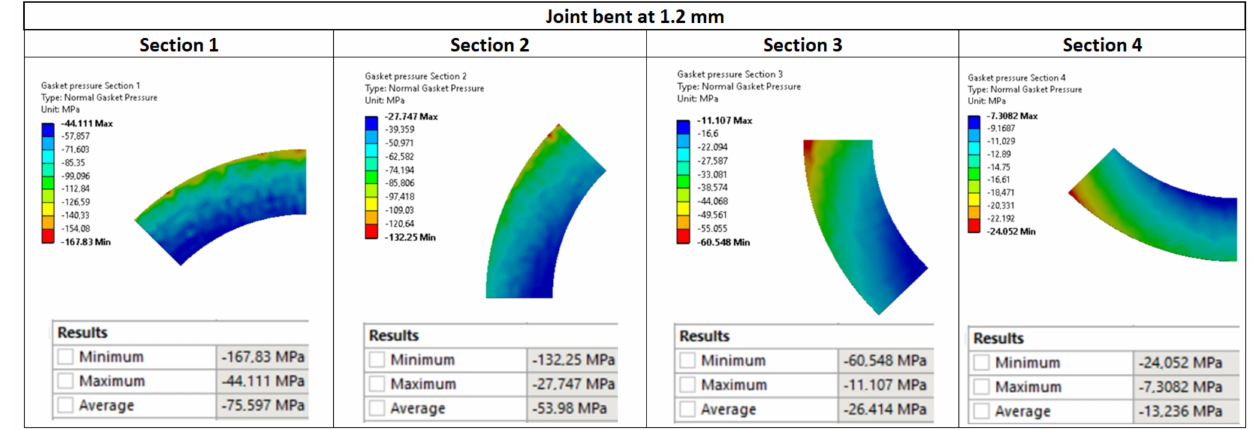
Figure 22. Pressure distribution in the characteristic zones of the gasket—1.2 mm deflection.